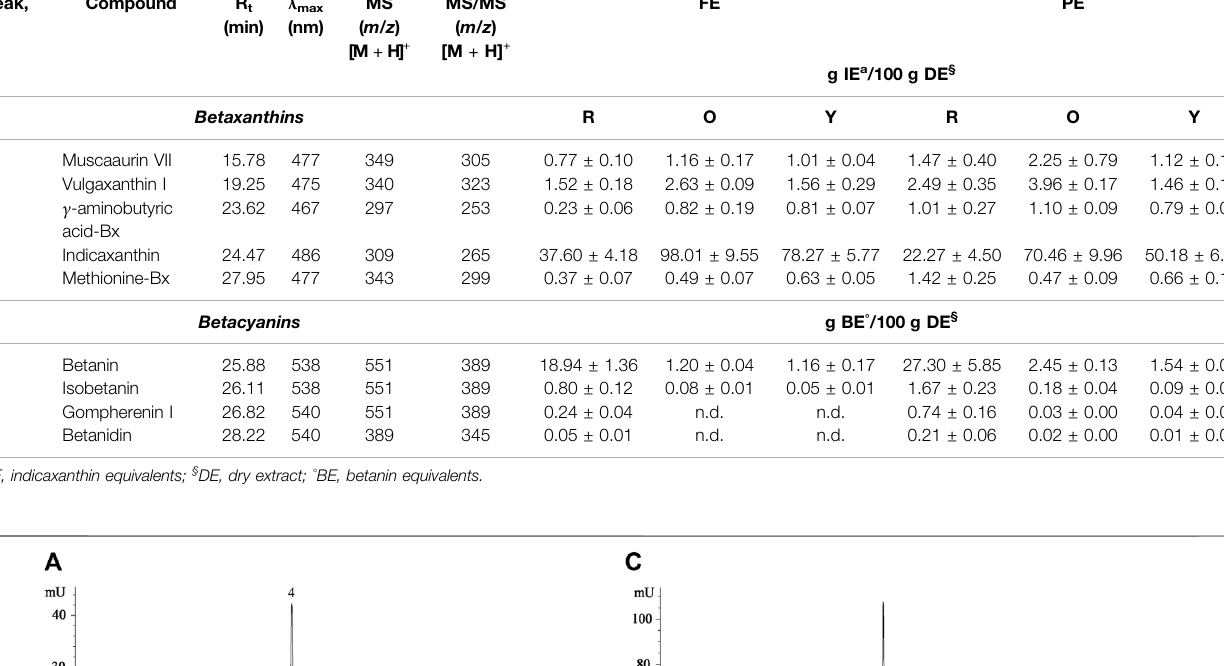
TABLE1| Betalainicpro fi leinred(R),orange(O),andyellow(Y)pricklypear fl eshandpeelextracts(FEsandPEs,respectively)byLC-DAD-ESI-MS/MSanalysis.Resultsare expressed as mean ± standard deviations of ten independent experiments ( n (cid:2) 3). Peak,